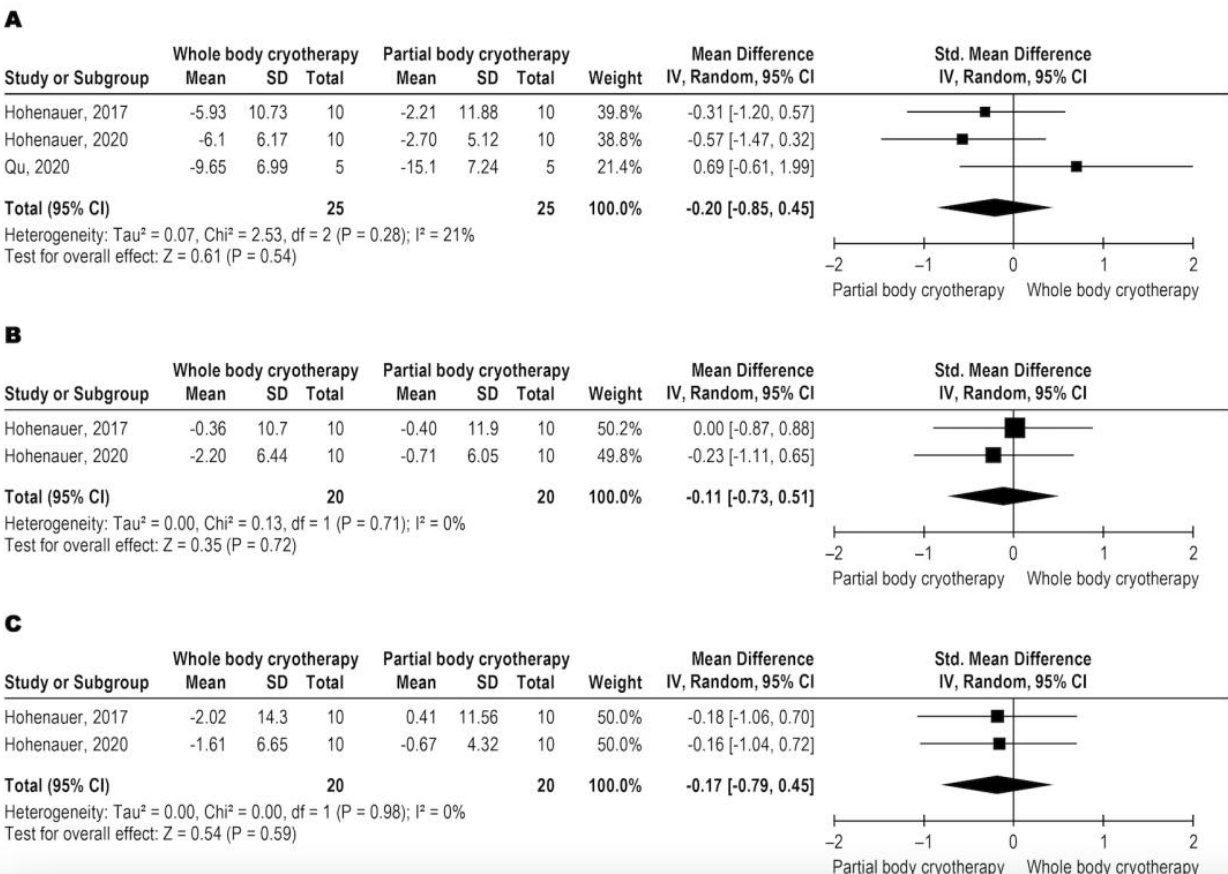
Figure 3C for 48 h with SMD: − 0.17 and CI 95%: − 0.79, 0.45, p = 0.59.